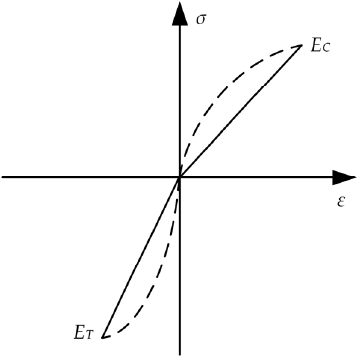
Figure 2. The stress–strain curves depicted by the bi-linear model.